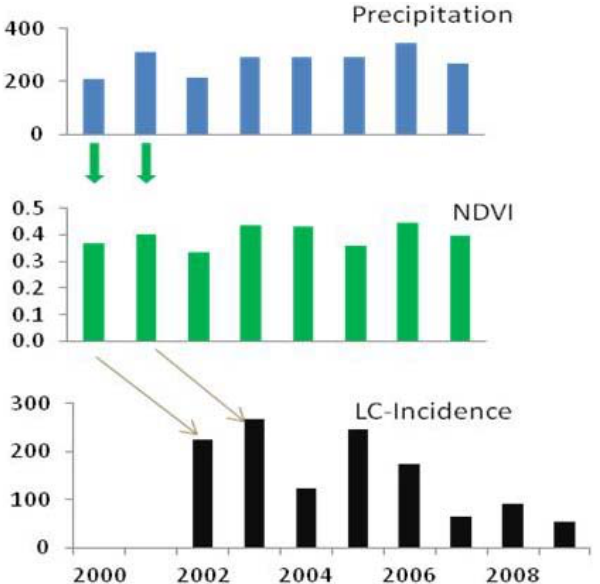
Figure 4. Relationship between precipitation, NDVI, and ZCL-incidence in the province of Saida. Rainy season (September through April) precipitation, growing season (February through May) vegetation density and annual total ZCL-cases. Note the correspondence of pattern dynamics between temporal changes of precipitation and NDVI values. The ZCL-cases lag precipitation and vegetation by two